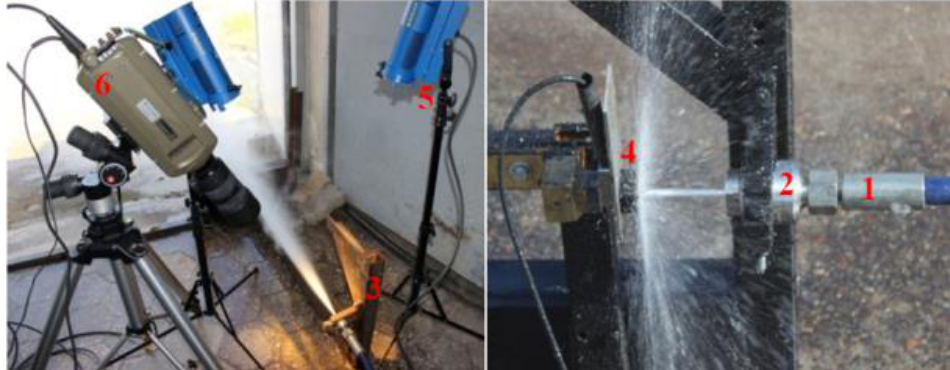
Figure 9. Measuring stations for recording images of impulse and continuous water jets operating in the air medium: 1−high-pressure power cord, 2−self-excited pulse head, 3−head mounting bracket, 4−force sensor, 5−lighting, 6−Phantom V12.1 camera.